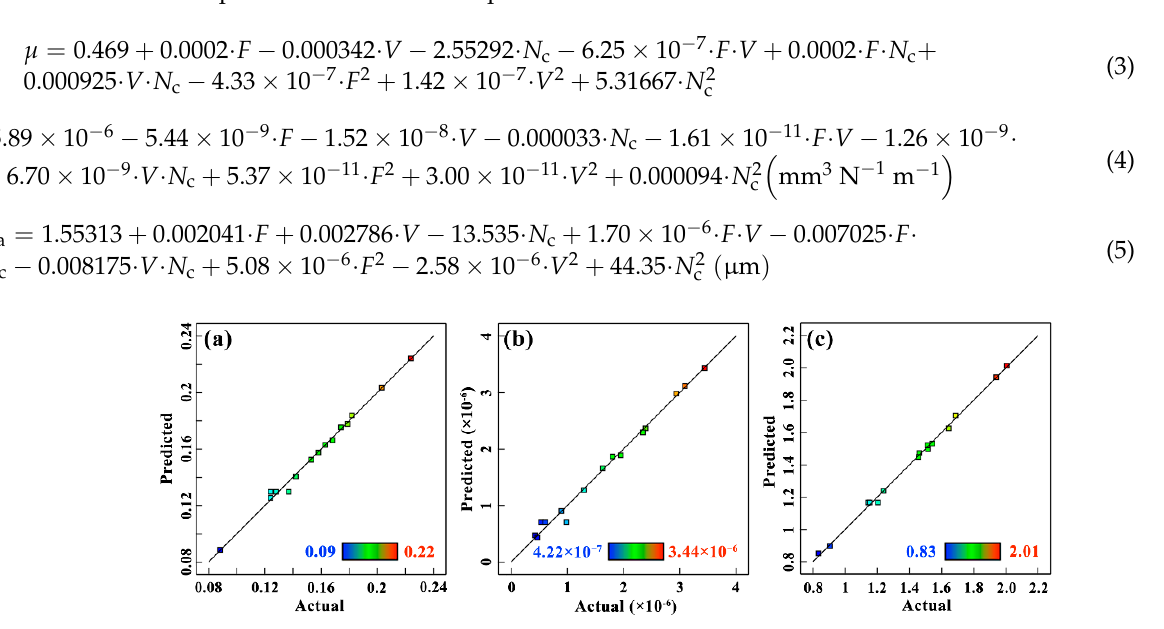
Figure 5. The parity plot illustrating the correlation between actual and predicted values for ( a ) μ , ( b ) W r and ( c ) R a . ( b ) W r and ( c ) R a